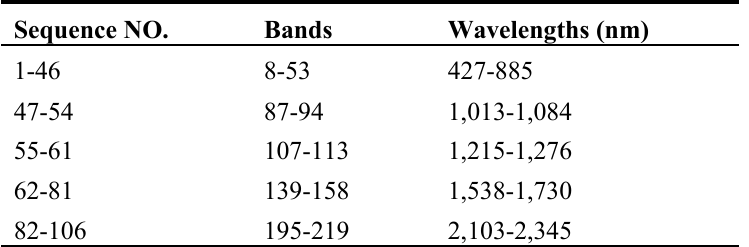
Table 1. Hyperion 106-band subset used in this